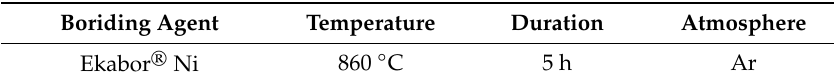
Table 2. Powder-pack boriding parameters.